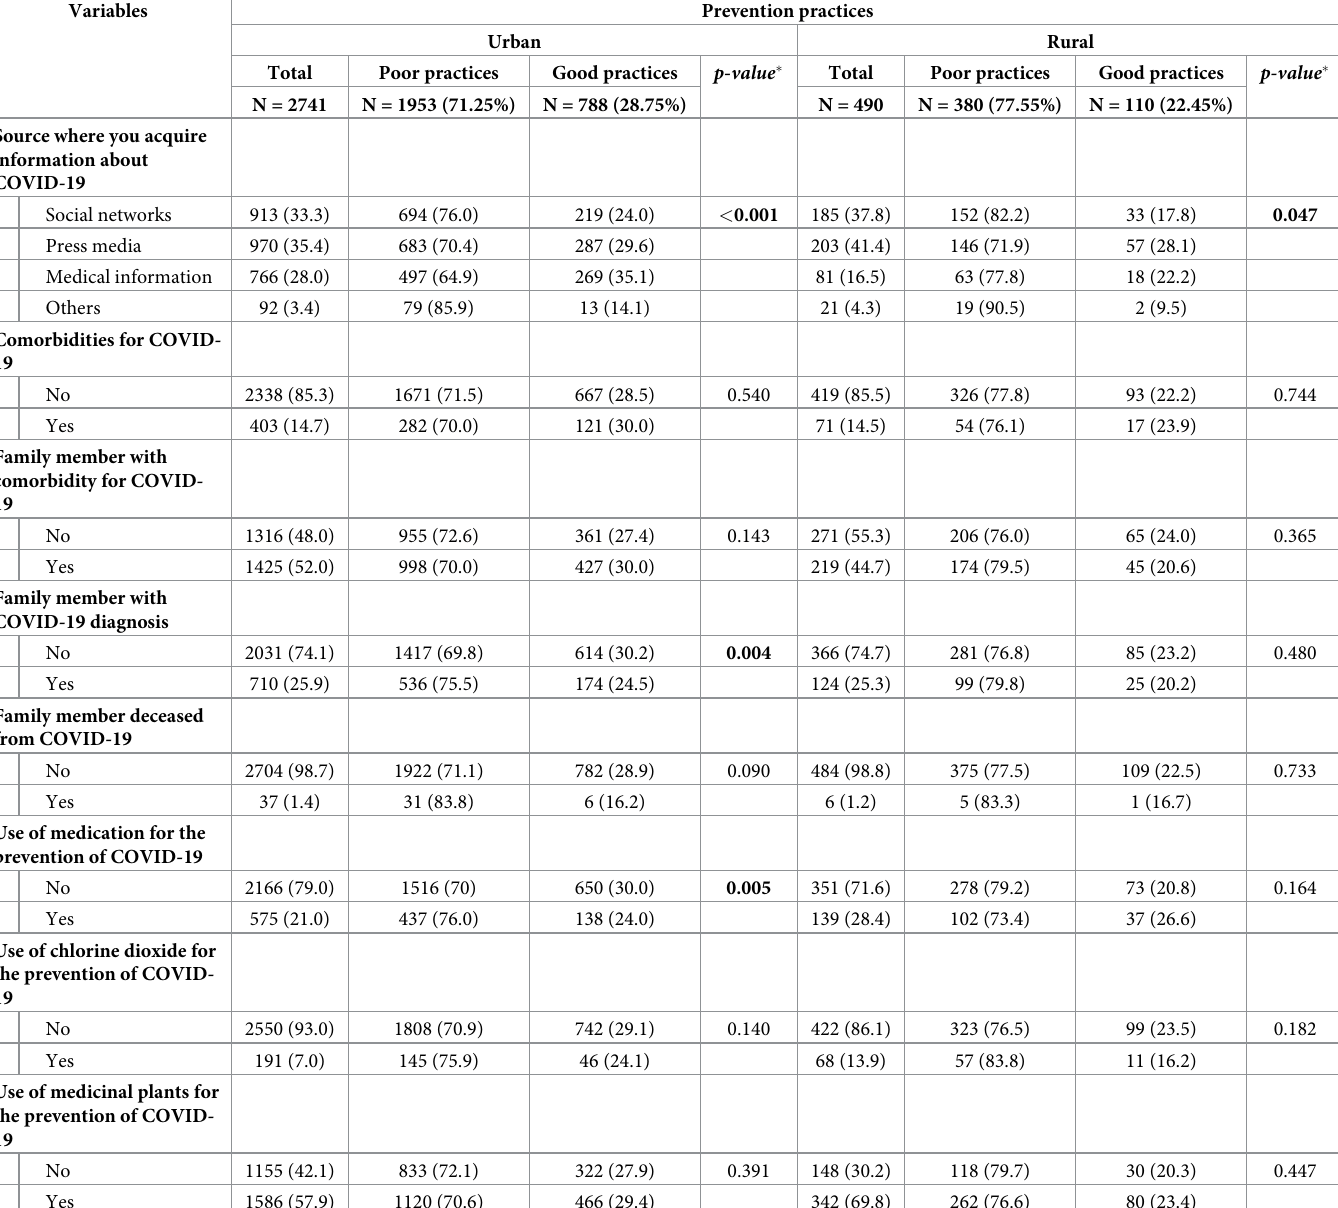
Table 2. Epidemiological characteristics of study participants, according to rurality strata and prevention practices (N = 3231).